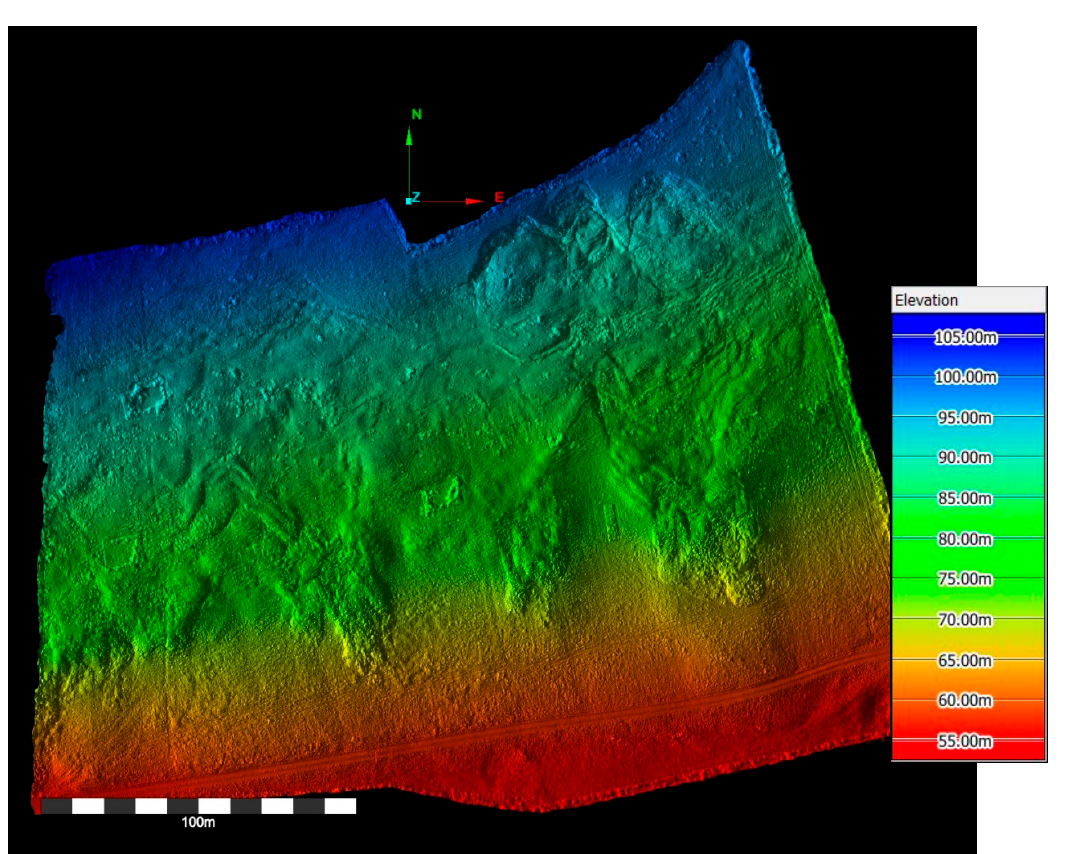
Remote Sens. 2021 , 13 , x FOR PEER REVIEW Figure 15. Elevation model of initial TLS survey of the Hollin Hill landslide. Figure 15. Elevation model of initial TLS survey of the Hollin Hill landslide.